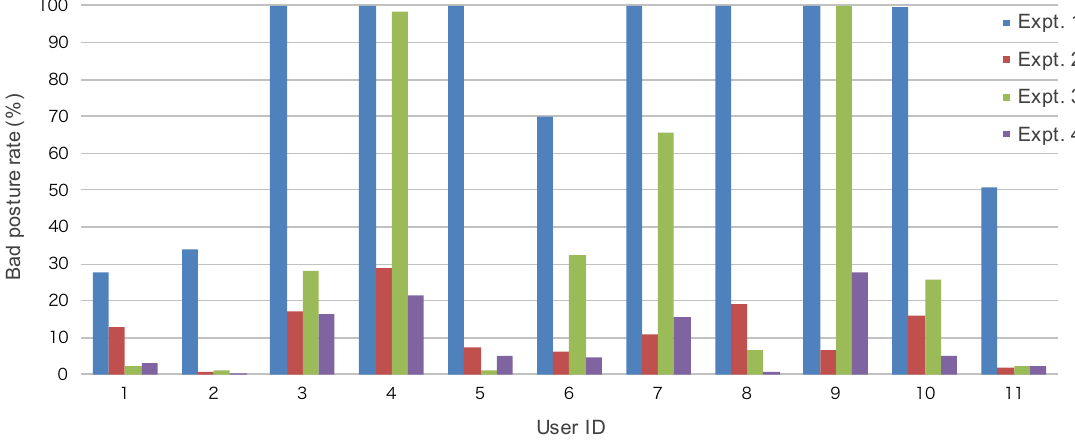
Figure 16. Experimental results of intervention to improve sitting